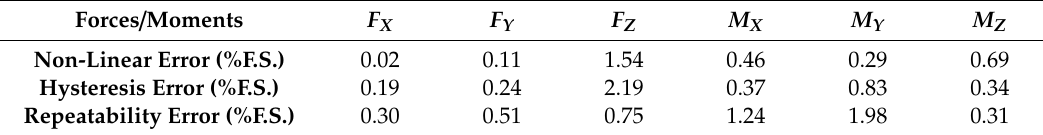
Table 3. Static performance indices of the cylindrical traction force sensor.